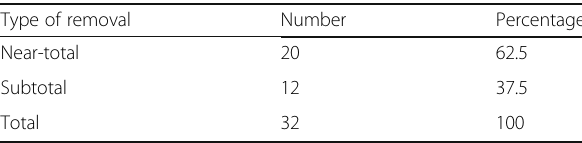
Table 1 Extent of resection